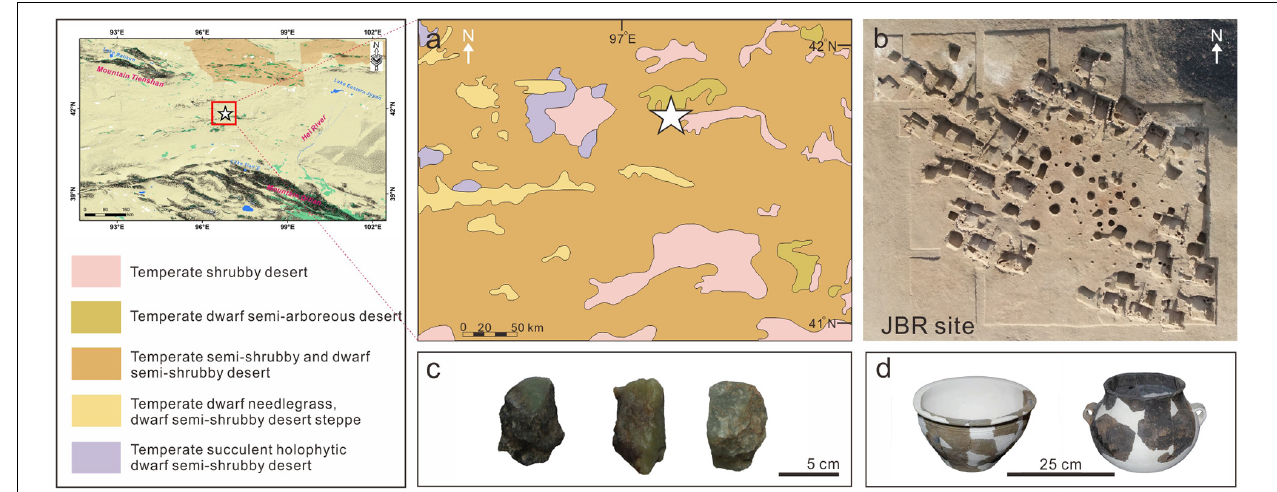
FIGURE 2 | Photos of the JBR jade mine site, excavated artifacts, and the distribution of vegetation around JBR. (a) Distribution of vegetation around JBR. (b) Excavation area at JBR. (c) Jade ores in JBR. (d) Shanma culture and Han dynasty ceramics from